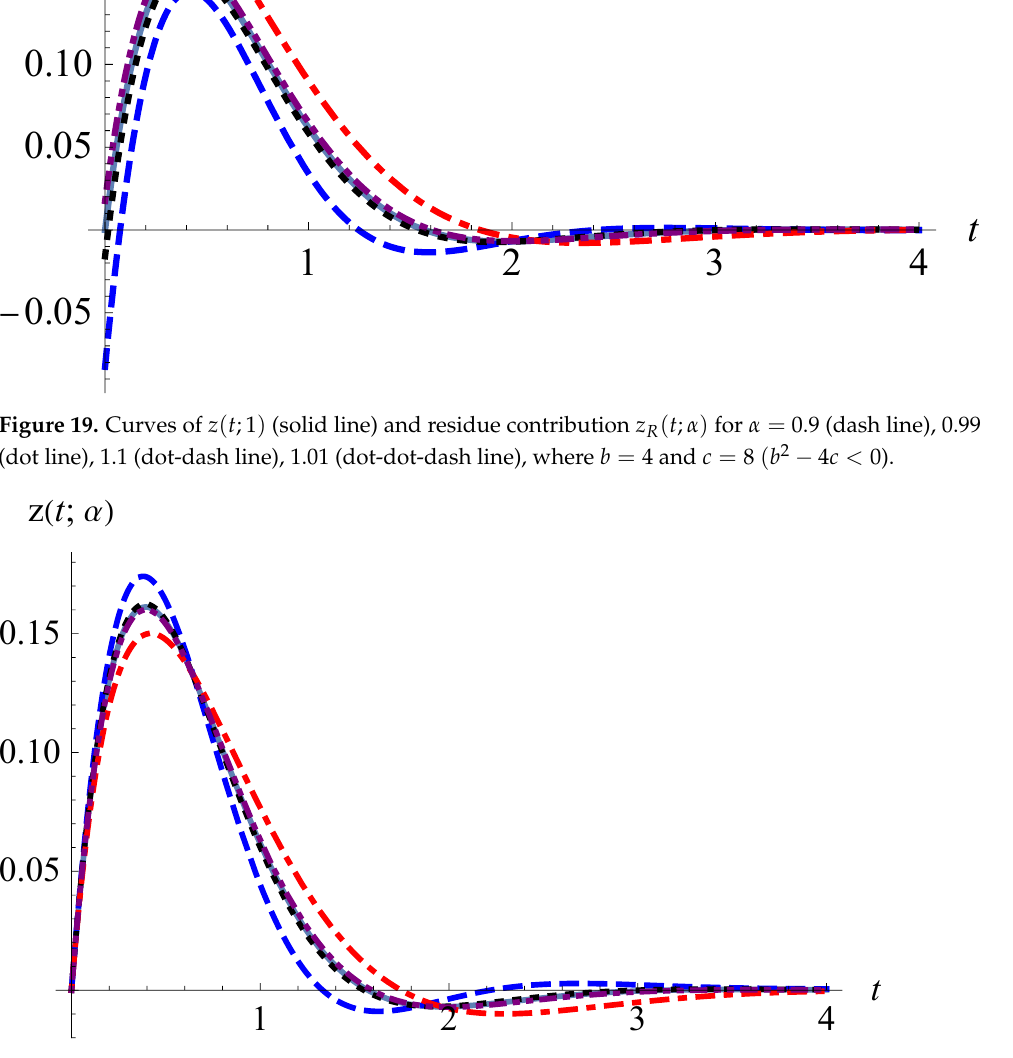
Figure 20. Curves of z ( t ;1 ) (solid line) and z ( t ; α ) for α = 0.9 (dash line), 0.99 (dot line), 1.1 (dot-dash line), 1.01 (dot-dot-dash line), where b = 4 and c = 8 ( b 2 − 4 c <